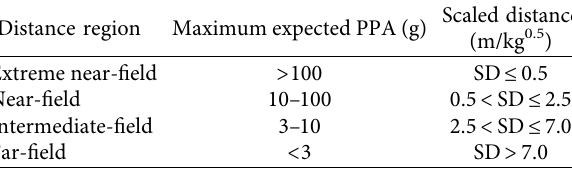
Table 2: Suggested definitions of tunnel blast monitoring regions.